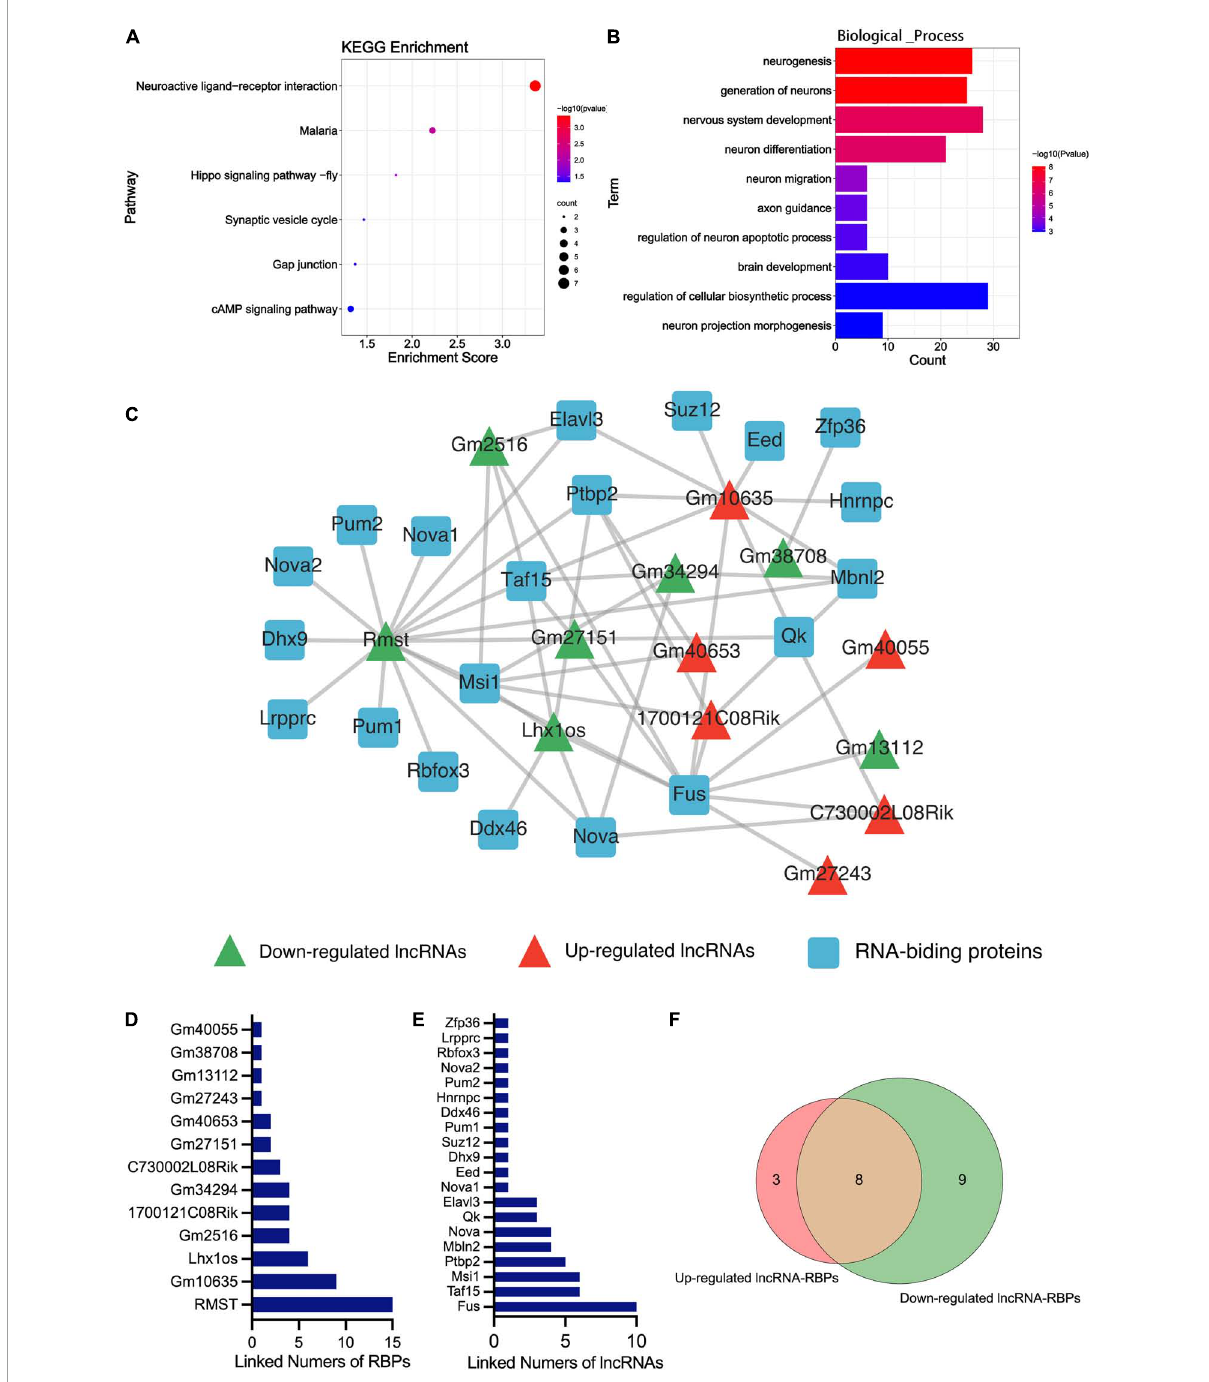
FIGURE4 Bioinformatics analysis results of the DEmRNA and DElncRNA. (A) The KEGG enrichment analysis of the DEmRNAs. The abscissa enrichment score represents the enriched extent of the pathway, and the ordinate represents each pathway. The size of the dots represents the number of genes in each pathway and the color of the dots represents the -log10 ( p -value); p -value was corrected by FDR. (B) The GO_BP enrichment analysis of the DEmRNA. The ontology only covered biological processes. The abscissa represents the count in the GO_BP term, the ordinate represents the GO_BP term, and the color of the column represents the -log10 ( p -value). (C) The lncRNA-RBPs regulatory networks. Green and red triangles represent the down-regulated and up-regulated DElncRNAs, respectively. The blue round rectangle represents the RNA-binding proteins. (D) The numbers of lncRNAs that connected RBPs. The abscissa represents the numbers of linked RBPs and the ordinate represents the lncRNAs. (E) The numbers of RBPs that connected lncRNAs. The abscissa represents the numbers of linked lncRNAs and the ordinate represents the RBPs. (F) Venn diagram showing the overlap number of RBPs of up-regulated and down-regulated